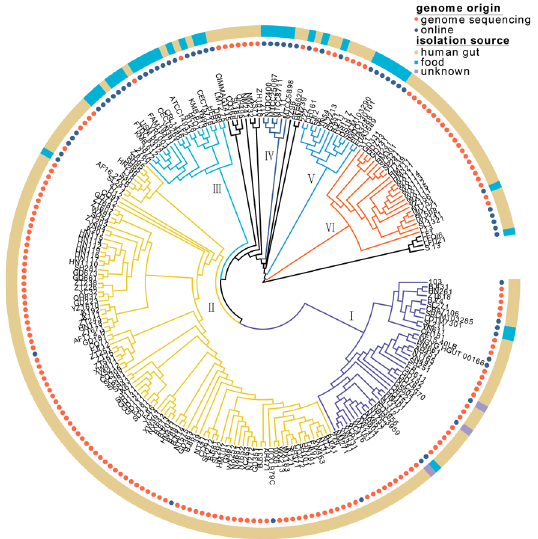
Figure 2. Phylogenetic analysis of 224 L. fermentum isolated from human intestinal tract and food based on 615 orthologous genes (All strains mainly clustered into phylogenetic clade I, II, III, IV, V, and VI). The genome origin is annotated with orange and blue circles and the isolation source of L. fermentum strains is notated with yellow, blue, and purple stripes.